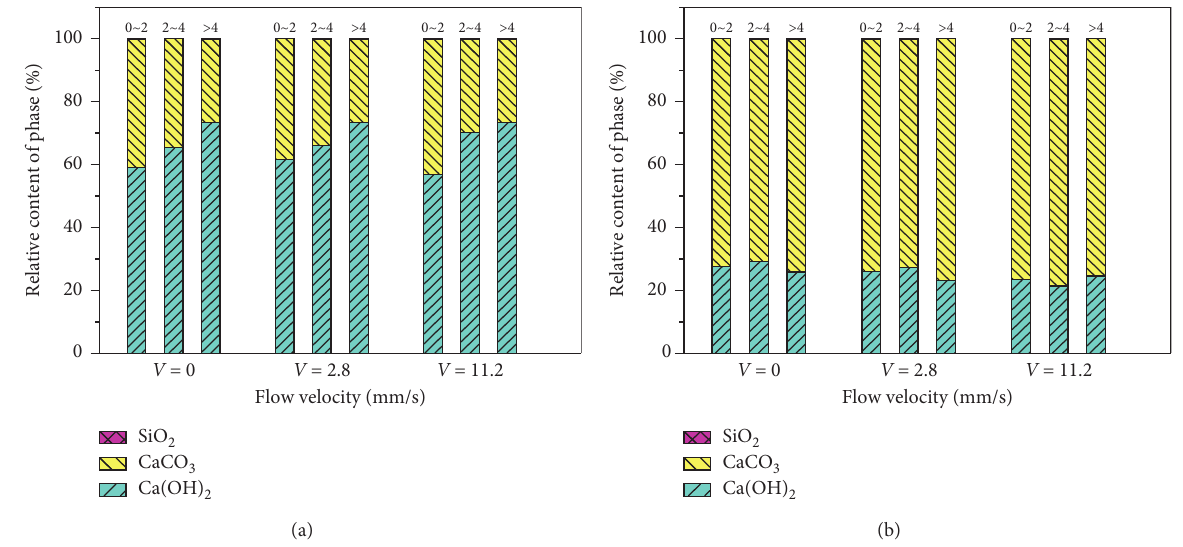
Figure 9: Mass fraction of phase for XRD-Rietveld quantitative analysis of 56d samples at different depths: (a) OPC; (b)